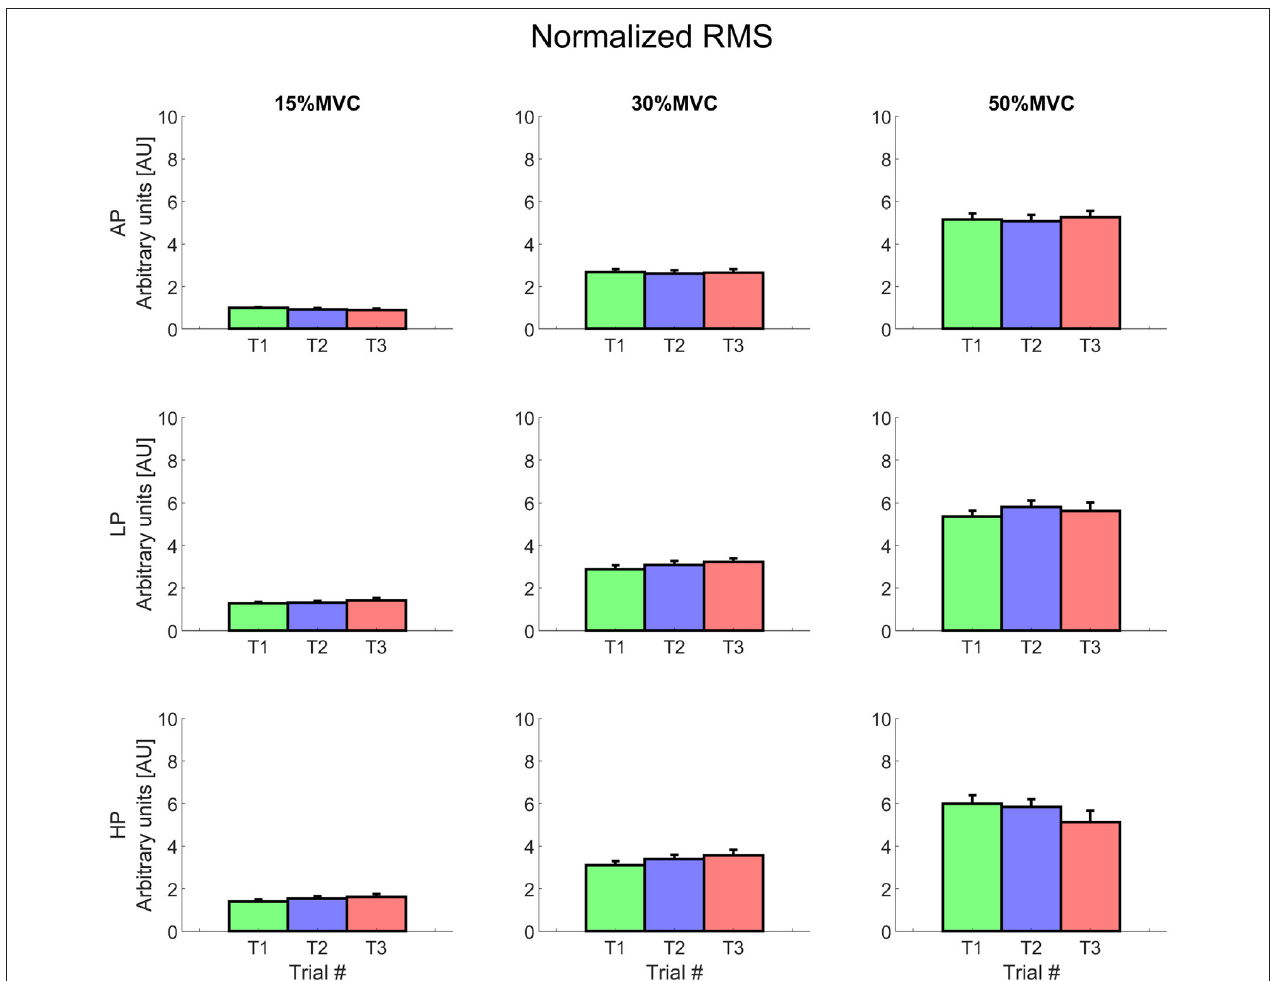
FIGURE 6 | Normalized root mean square value for each condition. Rows represent different levels of pressure, columns, different levels of torque. The data is represented as average and standard error across all the subjects for the three repetitions of the task. Trial 1 is represented in green, trial 2, in blue, and trial 3, in red. Data is normalized with respect to the MVC